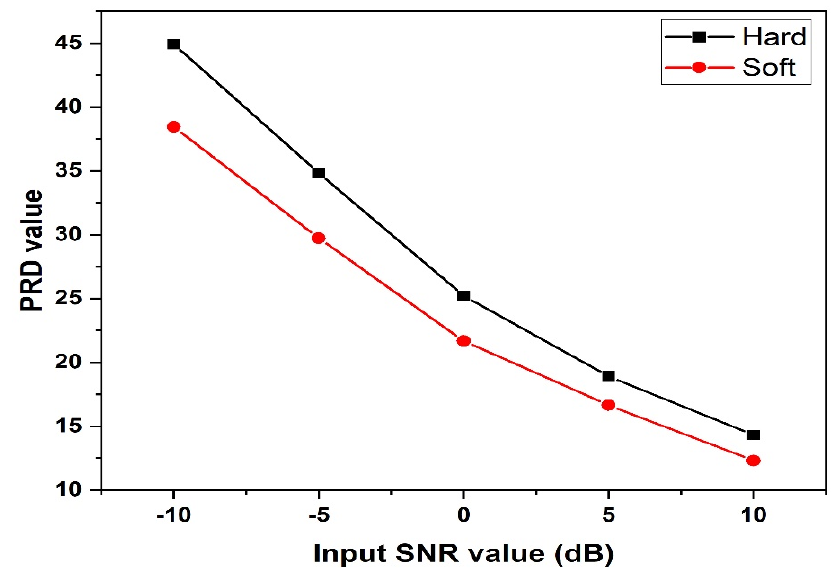
Figure 6. Performance comparison for different thresholding methods for record 100.